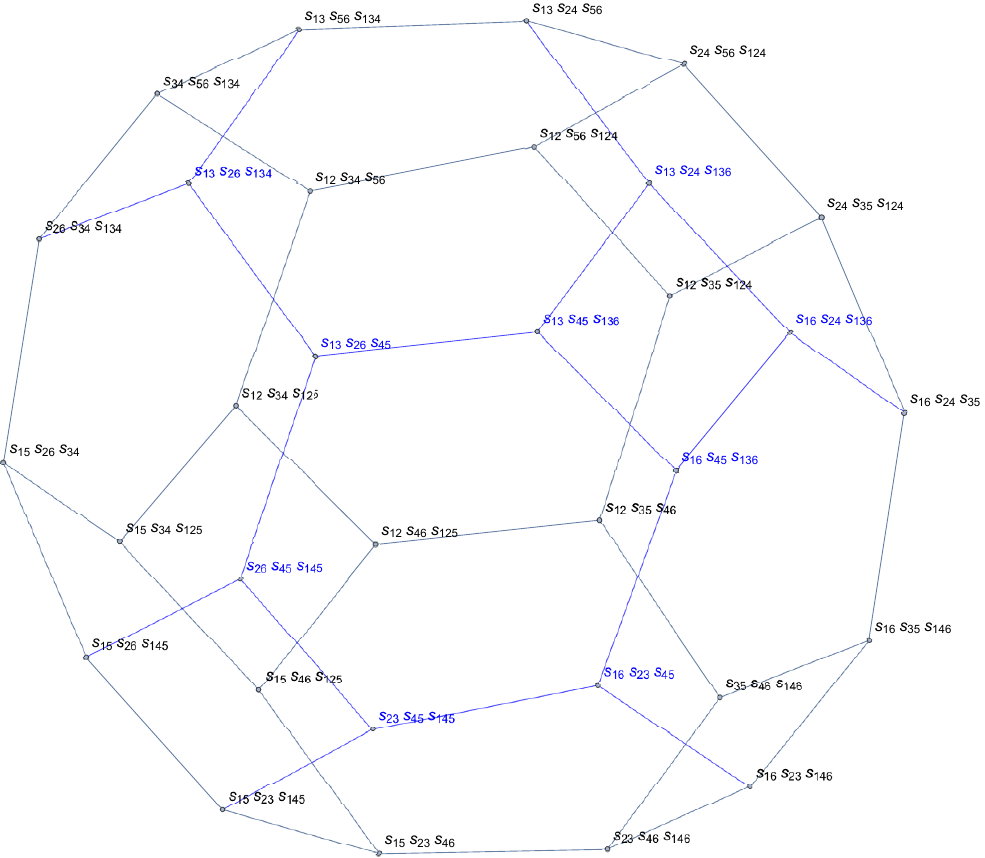
Figure 9. Combinatoric polytope from LS ( f (1 ; 2 ; 3) ; (3 ; 4 ; 5) ; (5 ; 6 ; 1) ; (2 ; 4 ; 6) g